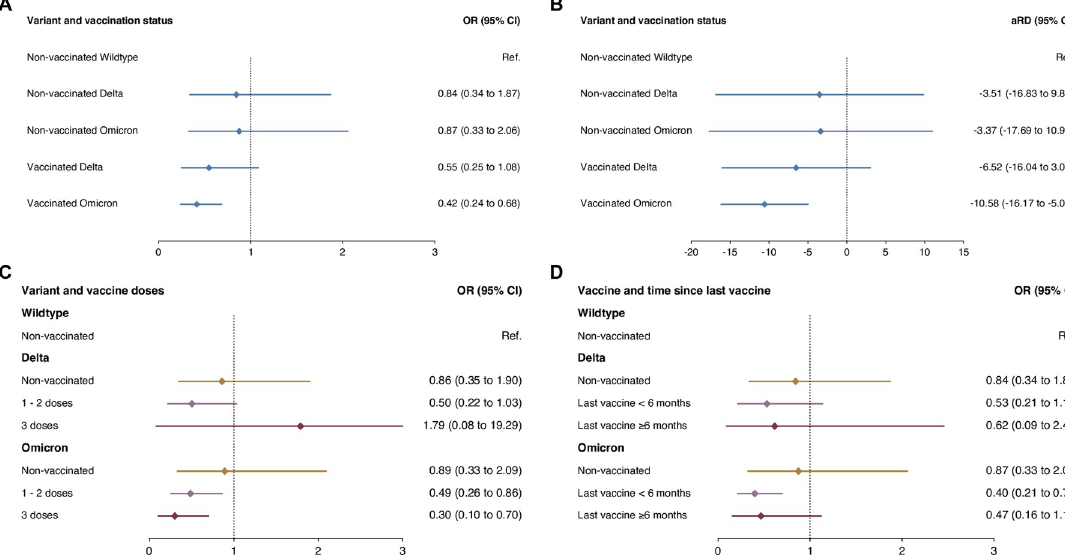
Fig 1. Association of Delta and Omicron SARS-CoV-2 infection and prior vaccination with post COVID-19 syndrome six months after SARS-CoV-2 infection. Panels A and B show odds ratios and adjusted risk differences among non-vaccinated and vaccinated individuals infected with the Delta or Omicron variant compared to non-vaccinated individuals infected by SARS-CoV-2, based on multivariable logistic regression models adjusted for age, sex, presence of comorbidities, initial hospitalization due to COVID-19, and prior infection. Panels C and D show odds ratios for having received one or two vaccine doses or three doses prior to infection and for having been vaccinated less than six months prior or six or more months prior to infection with the Delta or Omicron variants, based on multivariable logistic regression models adjusted for age, sex, presence of comorbidities, initial hospitalization due to COVID-19, and prior infection. Legend: aRD = adjusted risk difference, CI = confidence interval, OR = odds ratio, Ref. = reference group.